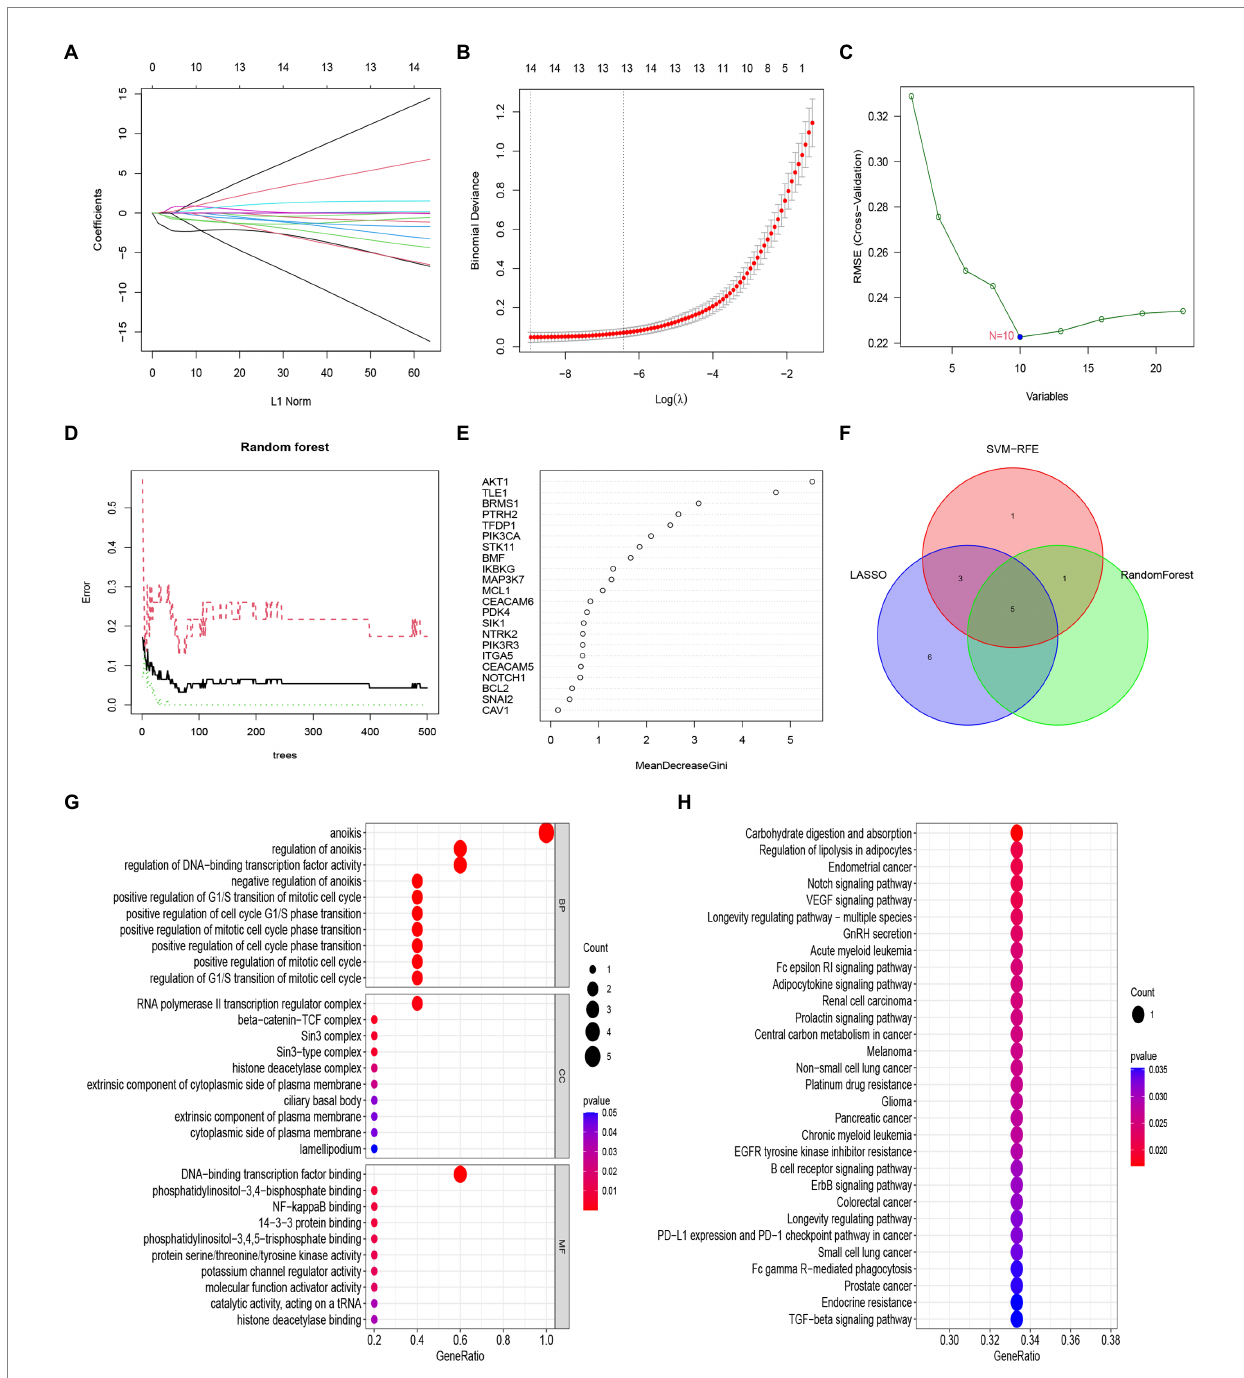
FIGURE 6 Construction and validation of the Lasso model, SVM model and RF model. (A) Fourteen cross-validations of adjusted parameter selection in the LASSO model. Each curve corresponds to one gene. (B) LASSO coefficient analysis. Vertical dashed lines are plotted at the best lambda. (C) SVM-RFE algorithm for feature gene selection. (D) Relationship between the number of random forest trees and error rates. (E) Ranking of the relative importance of genes. (F) Venn diagram showing the feature genes shared by LASSO, SVM-RFE algorithms, and random forest. (G) Bubble plot of GO analysis results based on the 5 feature genes. (H) Bubble plot of KEGG analysis results based on 5 signature